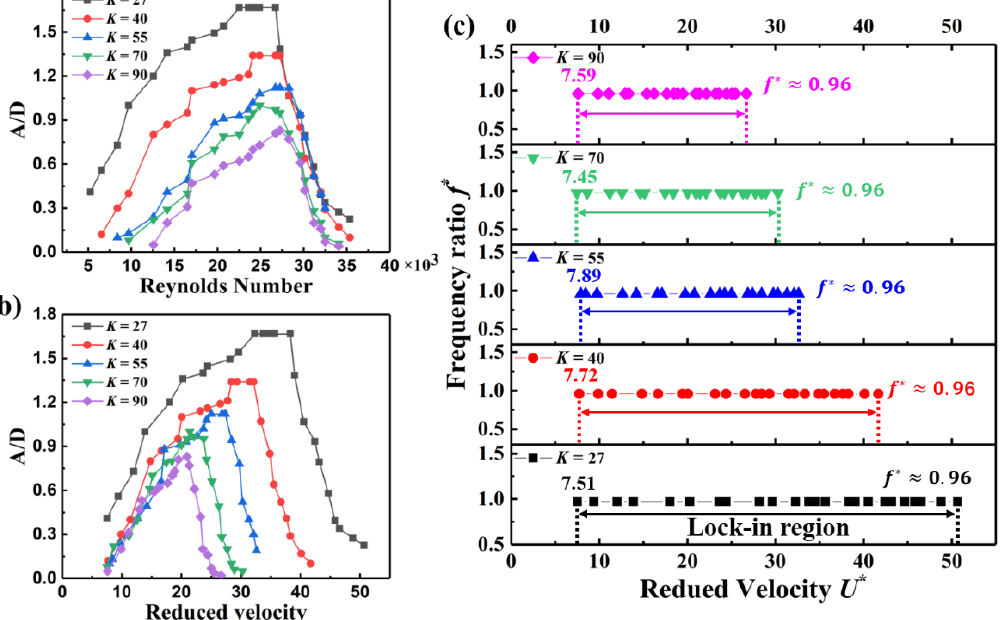
Figure 3. Vortex-induced vibration characteristics. ( a ) Amplitude ratio as a function of reduced velocity for different spring stiffness cases; ( b ) Amplitude ratio versus Reynolds number for different spring stiffness cases; ( c ) nondimensional frequency of response ( f * ) versus nondimensional velocity ( U * ) for different spring stiffness cases.